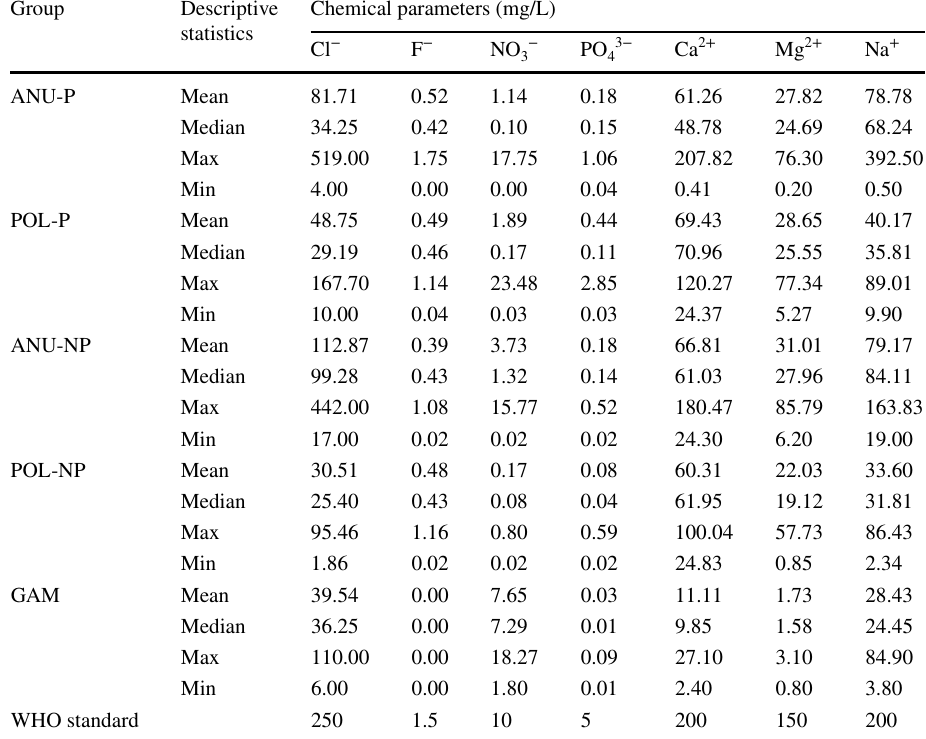
Group Descriptive